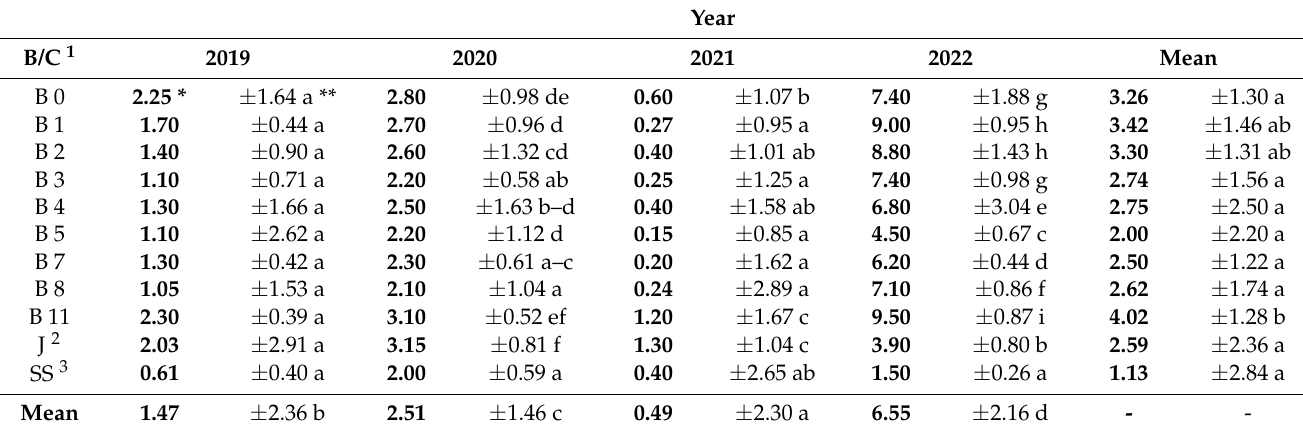
Figure 4. Cumulative yields (kg ∙ plant − 1 ) of Elaeagnus multiflora biotypes and cultivars in 2019–2022. Table 6. Yield (kg · plant − 1 ) of Elaeagnus multiflora biotypes and cultivars.